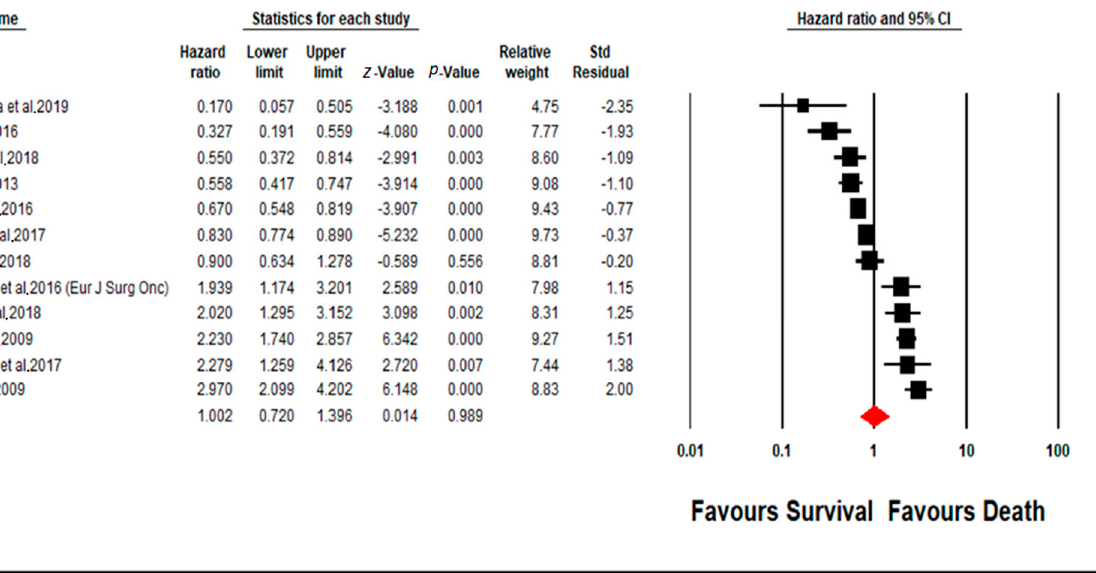
Figure 4. Forest plot of MLR subgroup.